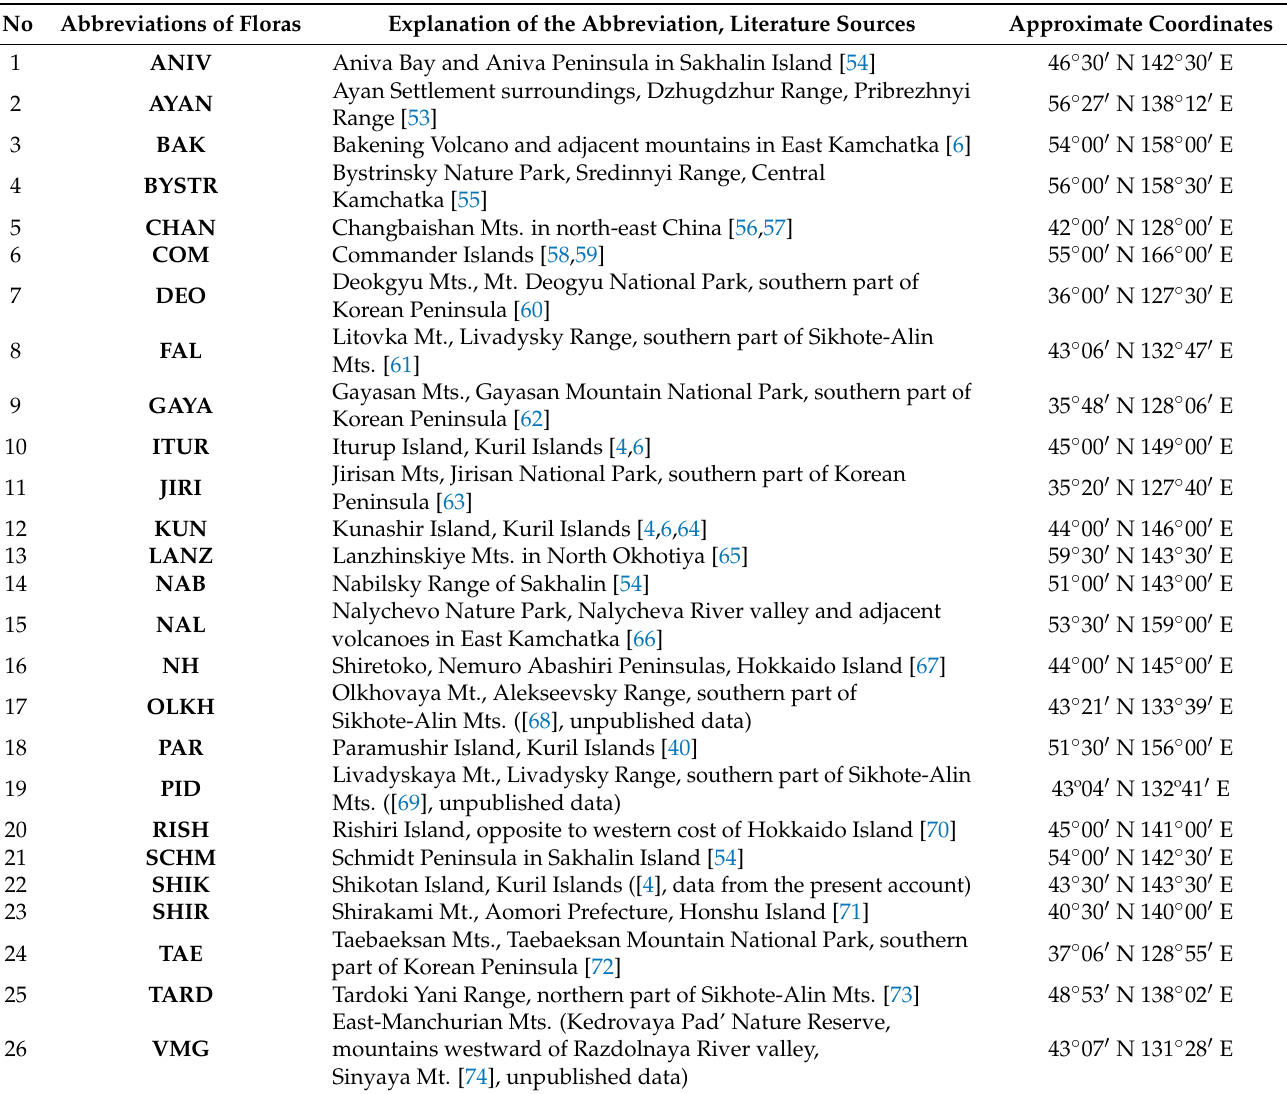
Table 4. The list of local flora involved in the